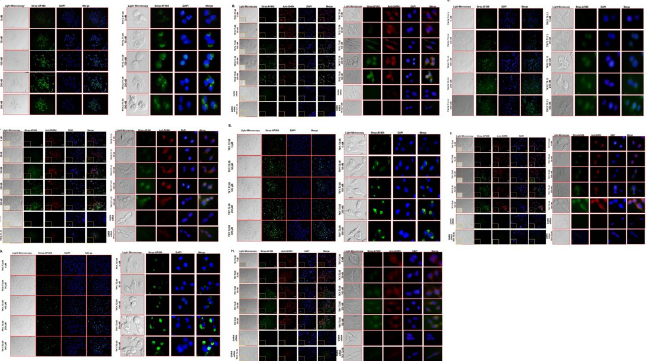
Fig 6. Investigation of the binding location of X-aptamers in MIA PaCa-2 cells. The binding position of A TKY2. T1.08, C TKY2.T1.13, E TKY.T2.08, G TKY.T2.09 x-aptamers were investigated by immunofluorescence. Streptavidin- Alexa Fluor 488 conjugate was used to specify biotin-labelled x-aptamers. Cells were treated with X-aptamers in a dose-dependent manner (0–500 nM). Following incubation, cells were examined under a fluorescence microscope (Olympus) and images were taken and analyzed. The binding position of B TKY2.T1.08, D TKY2.T1.13, F TKY.T2.08, H TKY.T2.09 x-aptamers investigated by co-immunofluorescence. Streptavidin-Alexa Fluor 488 conjugate was used to specify biotin-labelled X-aptamers. Streptavidin-Alexa Fluor 588 conjugated anti-GHRH was used to specify GHRH. Cells were treated with x-aptamers in a dose-dependent manner (0–500 nM). Following incubation, cells were examined under a fluorescence microscope (Olympus) and images were taken and analyzed. GHRH siRNA was used as a negative control.